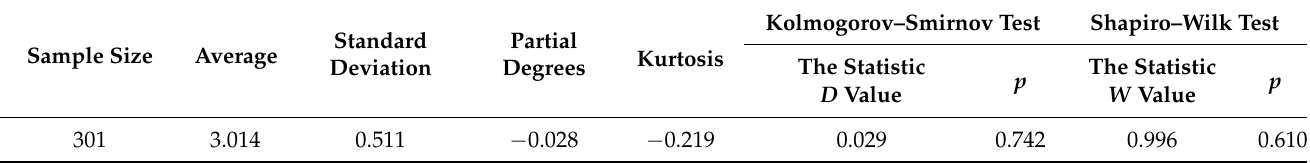
Table 4. Normal test analysis results.